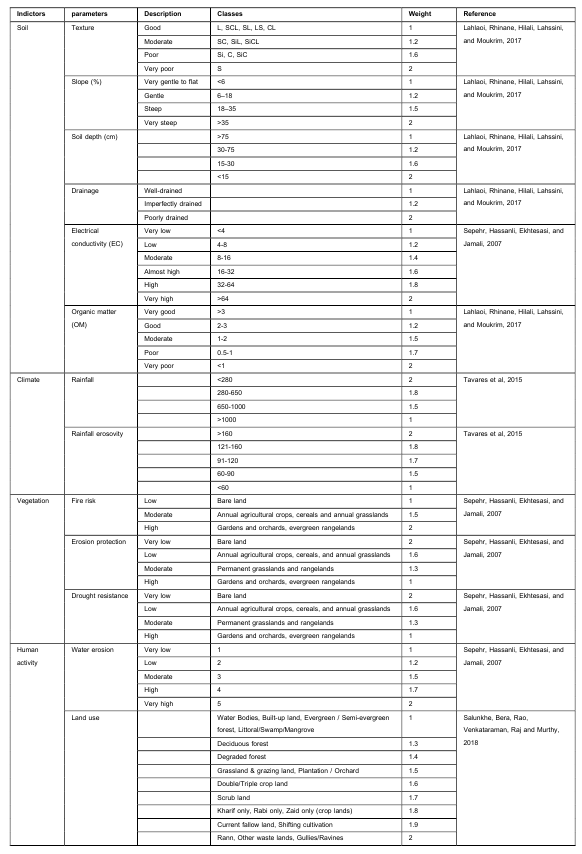
Table 1. Classes and assigned weighting index for parameters